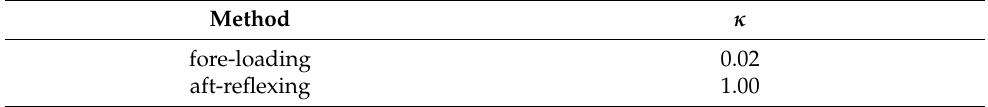
Table 7. The efficiency factor κ of fore-loading and aft-reflexing the tip airfoil.